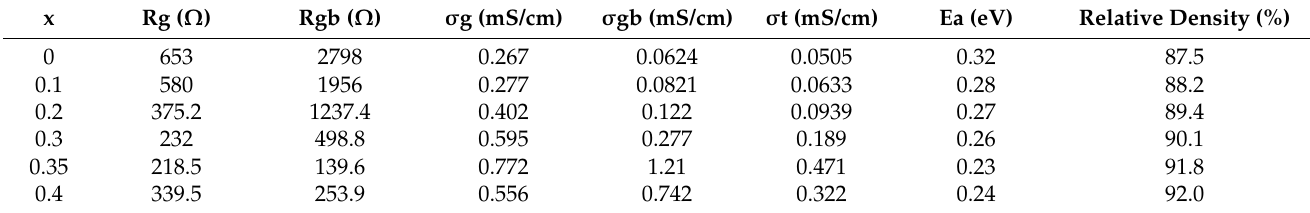
Table 2. Grain impedance (Rg), grain boundary impedance (Rgb), grain conductivities ( σ g), grain boundary conductivities ( σ gb), total conductivities ( σ t), activation energy (Ea), and relative density of LATP-xSn (x = 0–0.4) solid